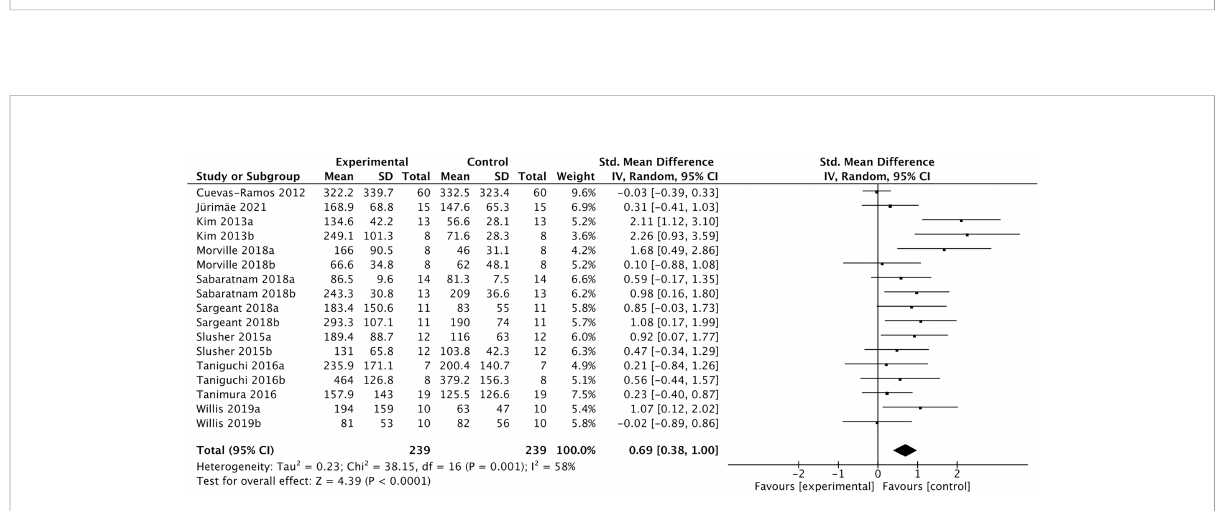
FIGURE 6 Forest plot of acute exercise effects on cFGF21 concentration sampled within 3 hours postexercise. Random effect models were used as the pooling method. The mean value refers to the mean cFGF21 concentration in each group. cFGF21, circulating fi broblast growth factor 21.